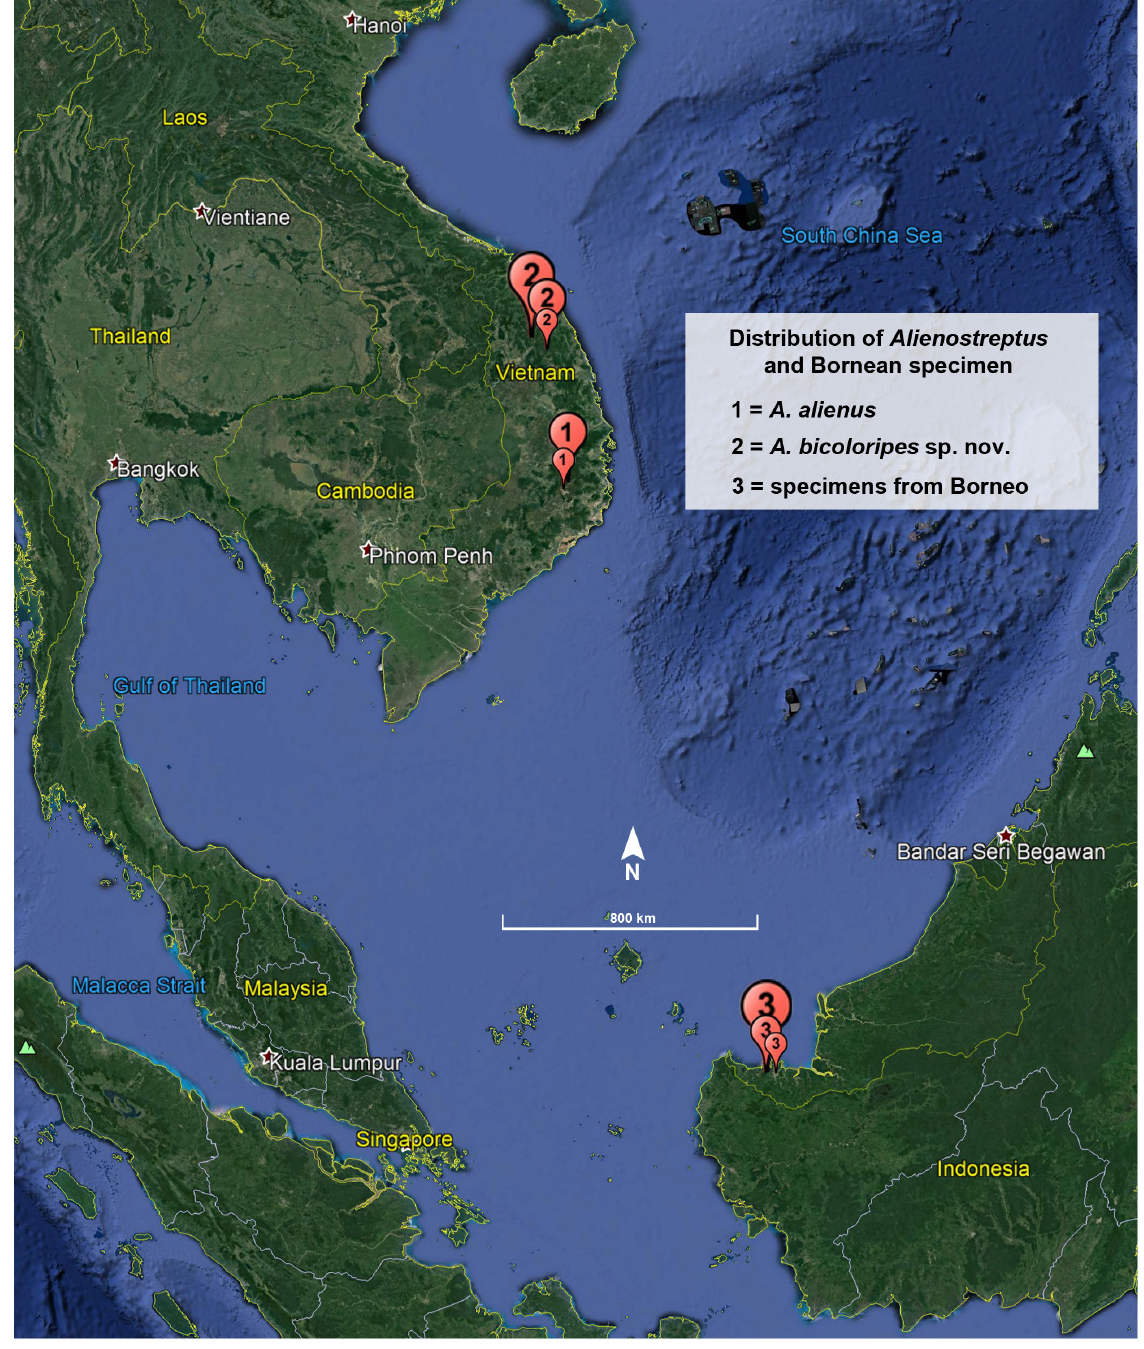
Fig. 8. Known distribution of Alienostreptus Pimvichai et al. 2010 spp. and superficially similar specimens from Borneo. Droplets vary in size only to improve